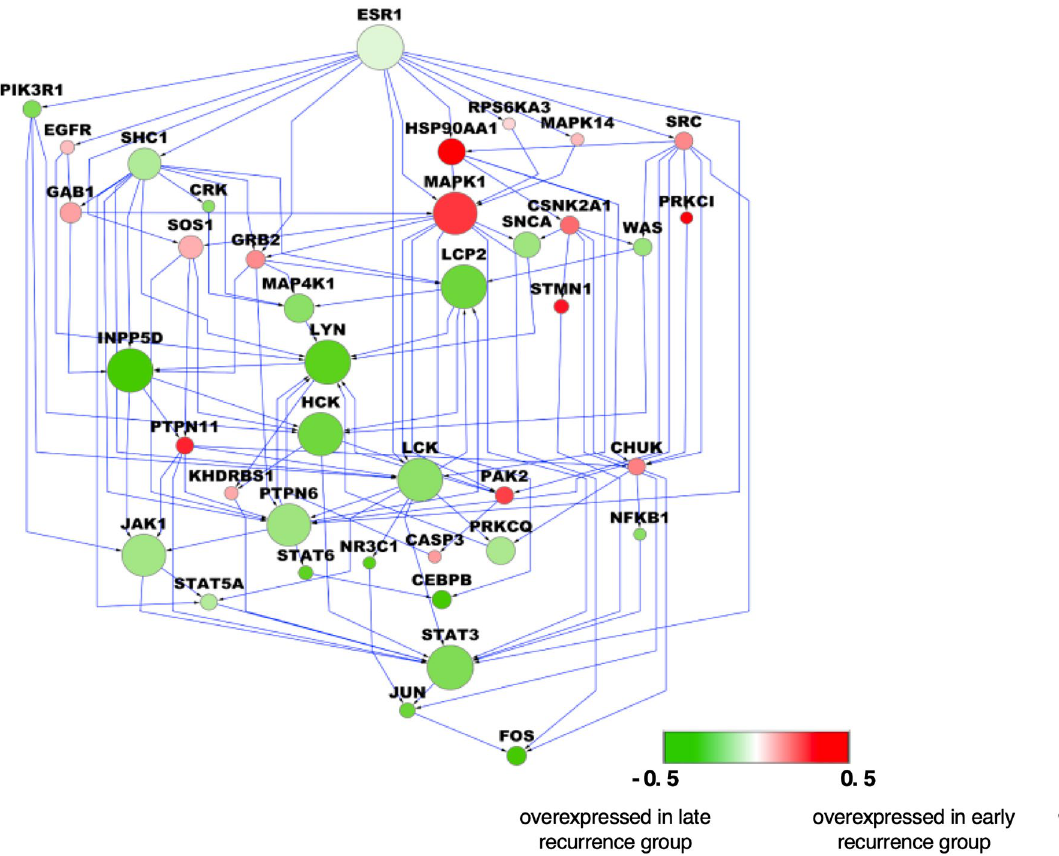
Figure 4. An ER signaling pathway network identified by IMPALA using Symmans data. Gene colors represent the log2 fold change of gene expression between ‘early recurrence’ and ‘late recurrence’ patients in the Symmans dataset (red: over-expressed in ‘early recurrence’ group; green: over-expressed in ‘late recurrence’ group). Gene size is proportional to the probability (sampling frequency) estimated by